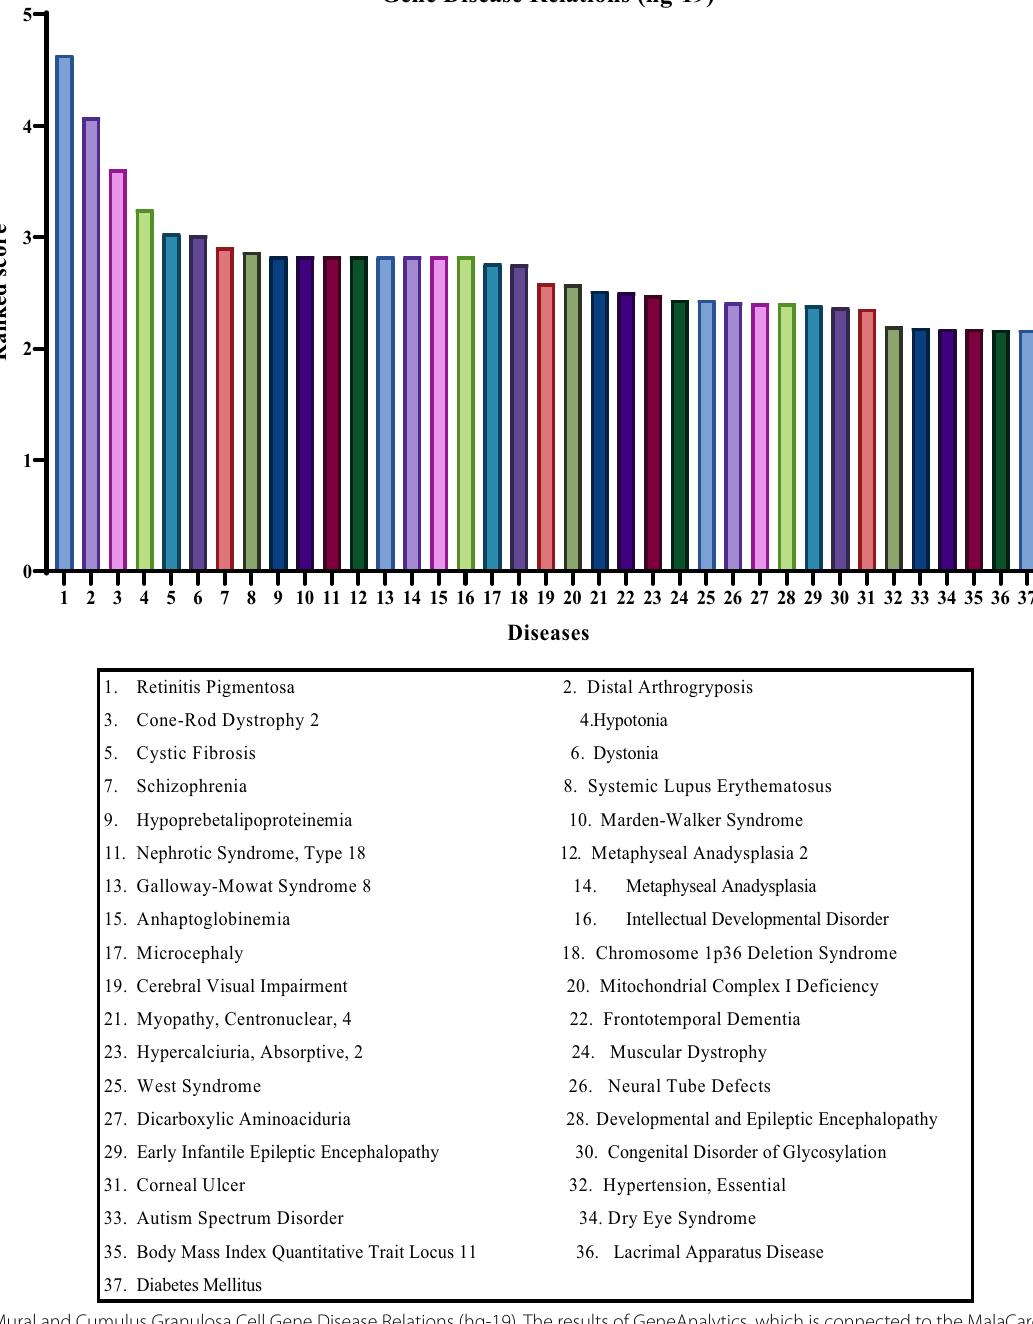
Fig. 4 Mural and Cumulus Granulosa Cell Gene Disease Relations (hg-19). The results of GeneAnalytics, which is connected to the MalaCards database, indicate the gene-disease association linkages of the Mural and Cumulus genes